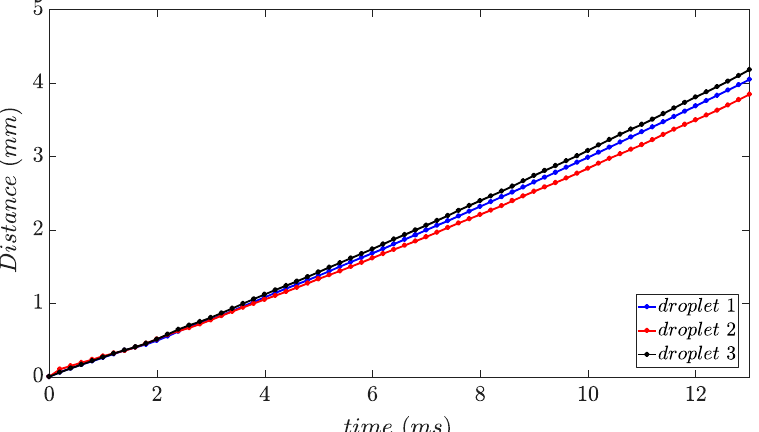
Figure 9. Droplet trajectories determined from high-speed recordings for three consecutive EN 1.3505 droplets during fall; valve opening time: 4 ms, 2945 mbar.